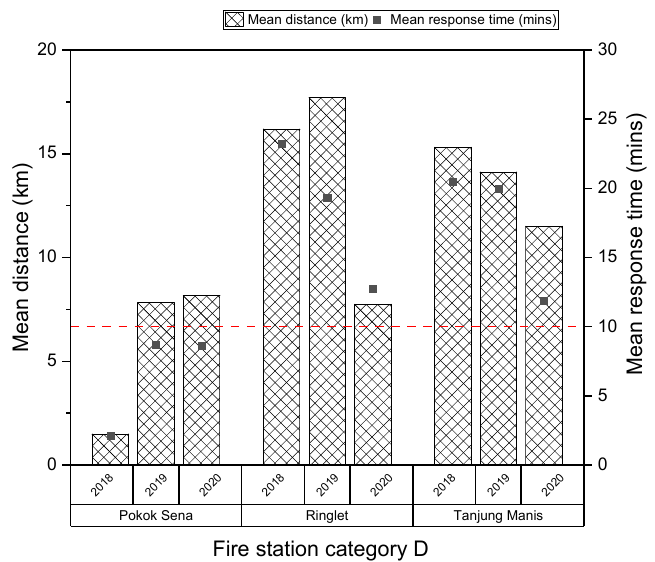
Figure 8. Mean distance travelled and response time recorded by category D fire stations. The red dash line is the mean response time benchmark for Malaysia.